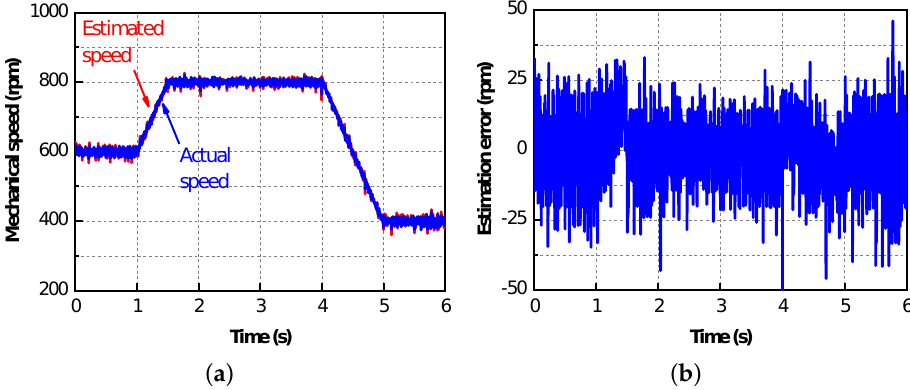
Figure 25. Experimental results.( a ) Estimated speed and ( b ) estimation error.